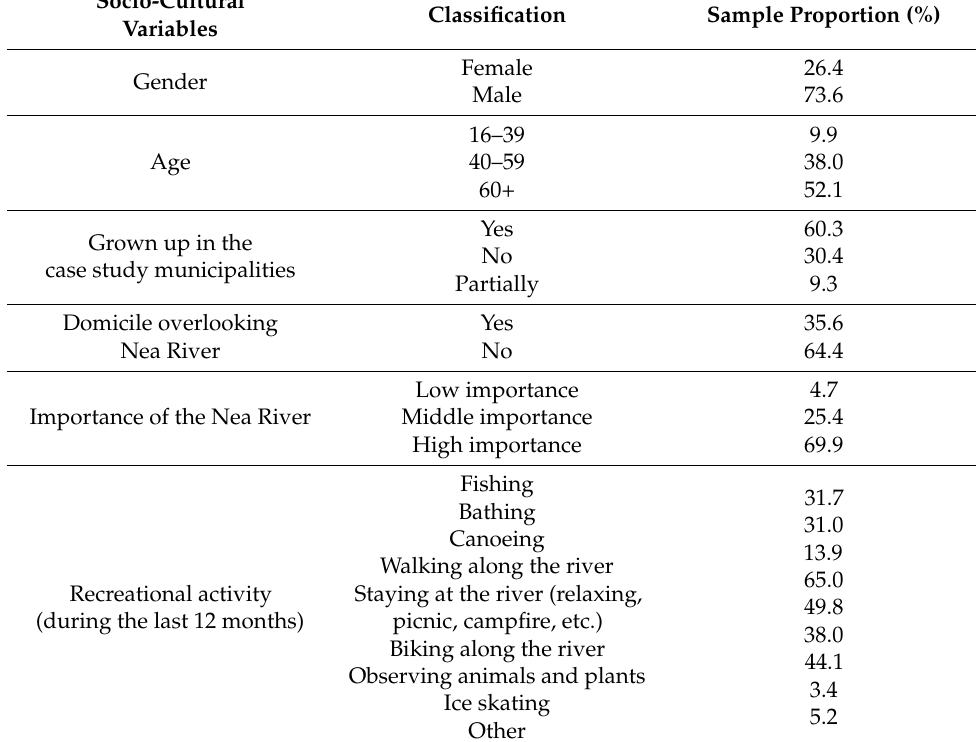
Table 2. Socio-cultural characteristics of survey